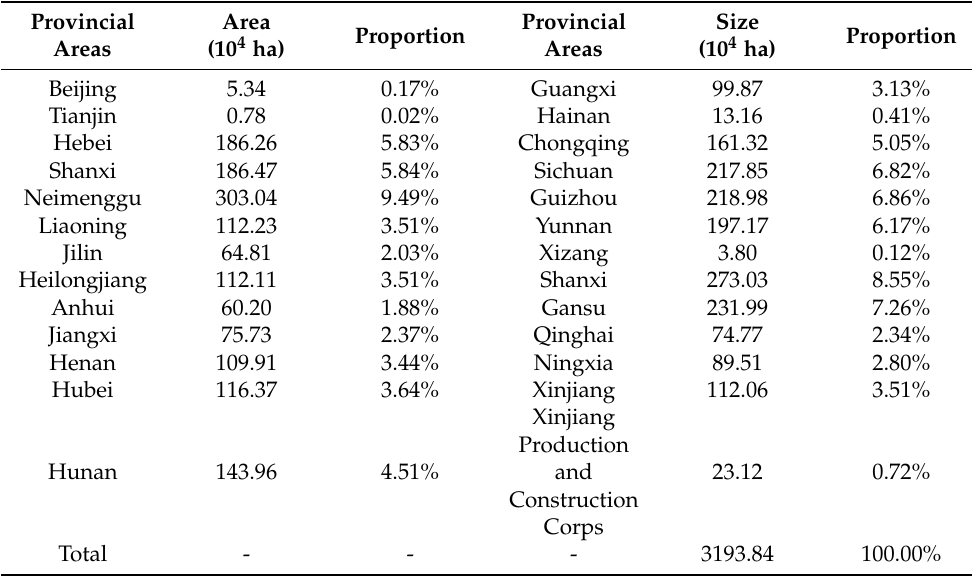
Table 1. Area of Grain for Green Project at the provincial